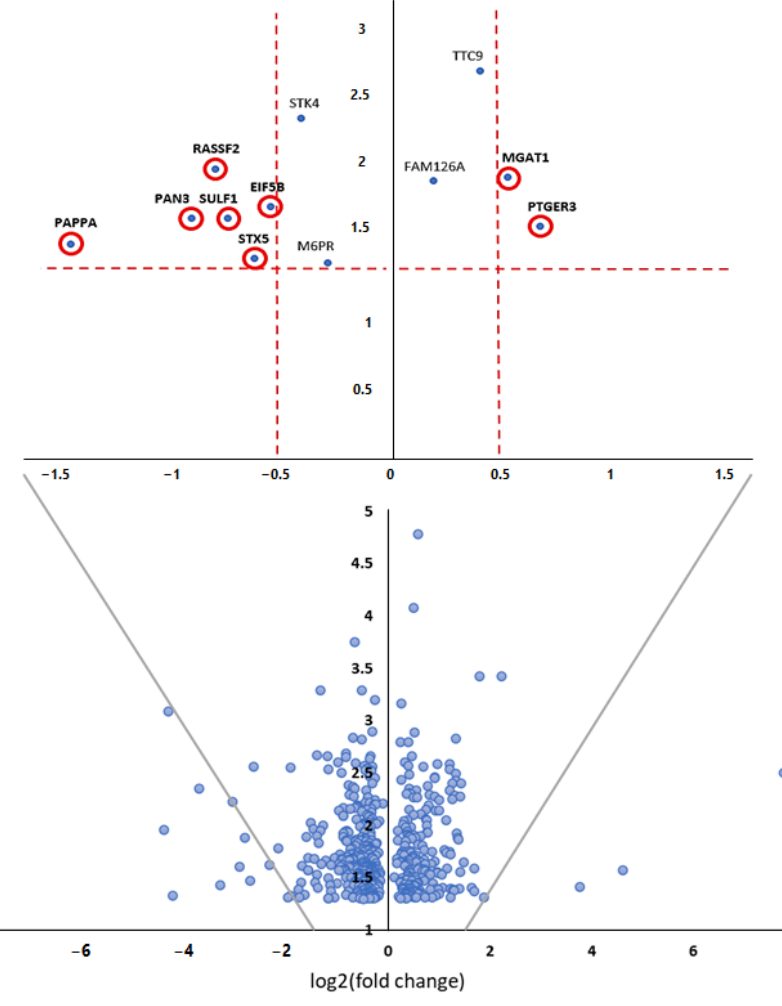
Figure 3. Volcano plot for the selection of the differentially expressed proteins. The 579 proteins with a p -value < 0.05 identified from the proteomic analysis (see Supplementary Material) are displayed. Extracted and plotted alone on top of the plot are the significantly dysregulated proteins (highlighted in red) as determined by cut-off values of − 0.5 > log2FC > 0.5 and − log10( p -value) > 1.3. Proteins with log2FC < 0 are downregulated in dilated vs. non-dilated segments, while proteins with log 2 FC > 0